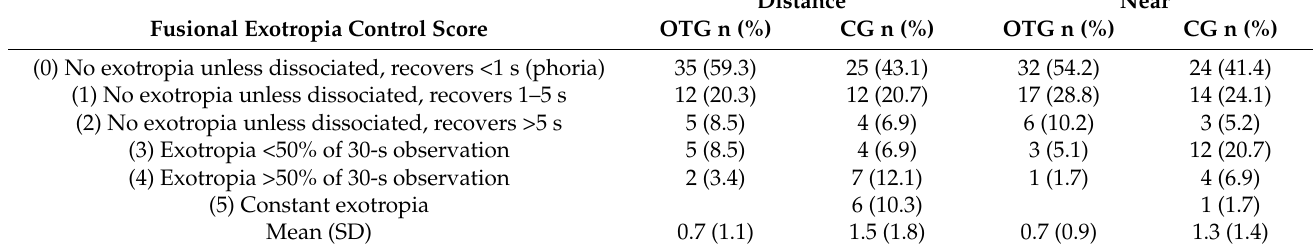
Table 5. Fusional Exotropia Control Score by 12 months in the orthoptic therapy group and the control group.